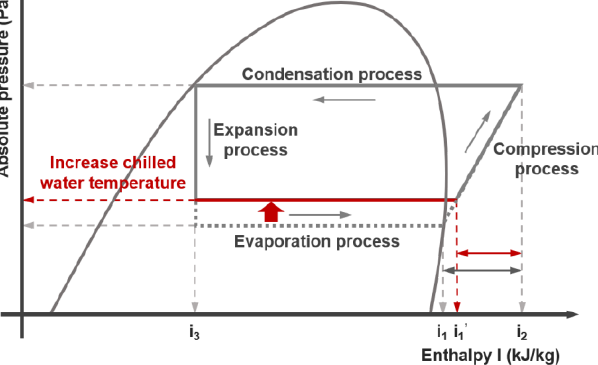
Figure 5. Mollier diagram with increasing chilled water supply temperature.